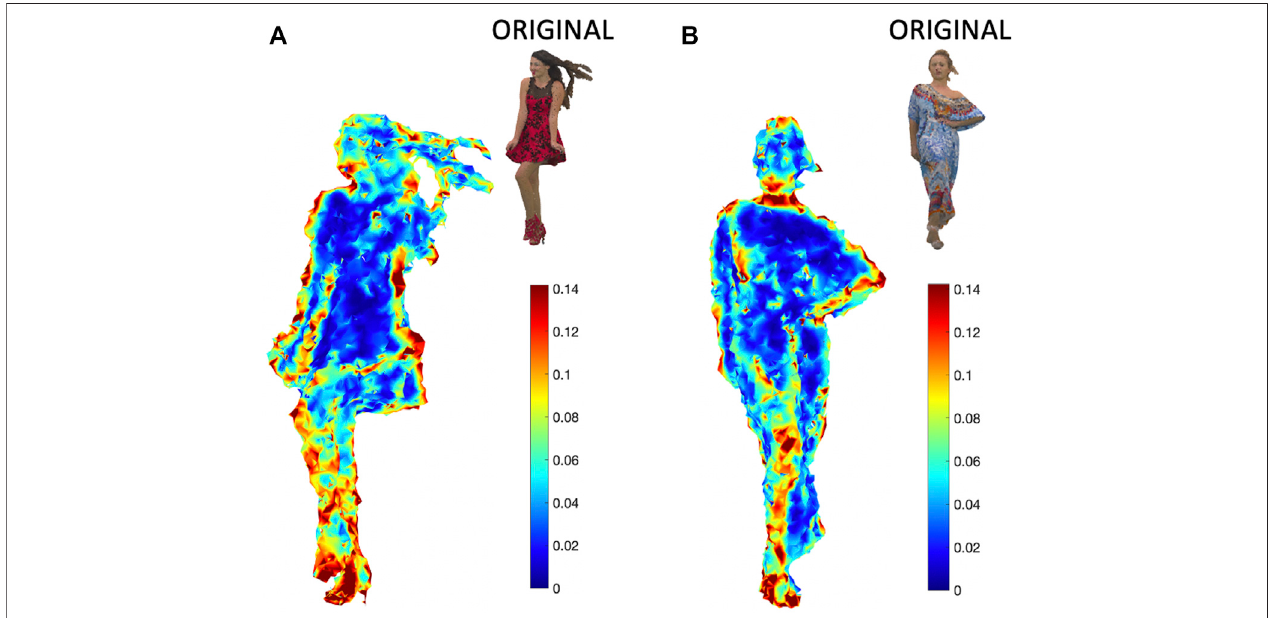
FIGURE 9 | MAHF applied on the point cloud normals for different data: (A) red and black and (B) long dress. In the insets of each panel, we have original images. Here, MAHFs are applied to the normals n p to the point cloud surface. We compute the square module of the MAHF output (cid:3) ν ( p i ) (cid:3) 2 i